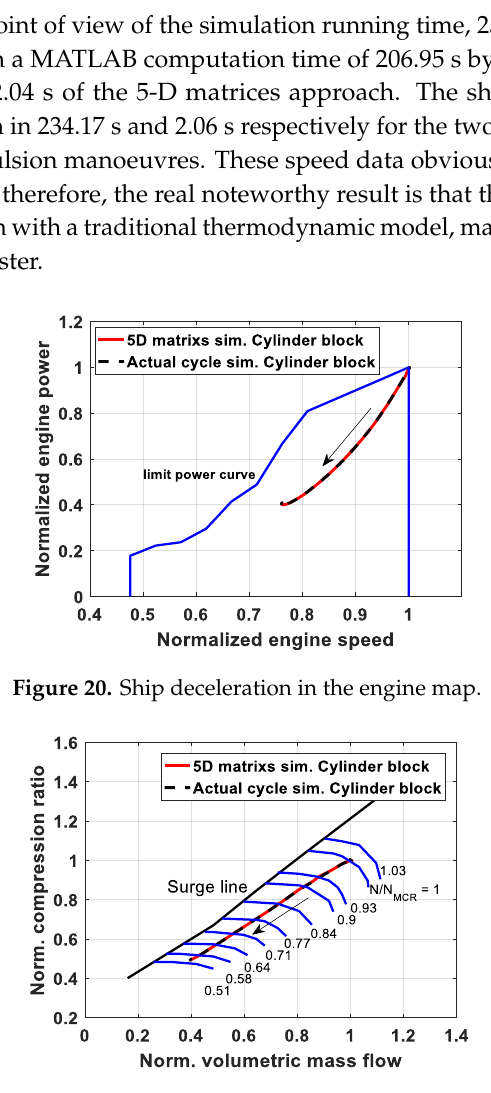
Figure 19. Fuel mass flow rate time history.